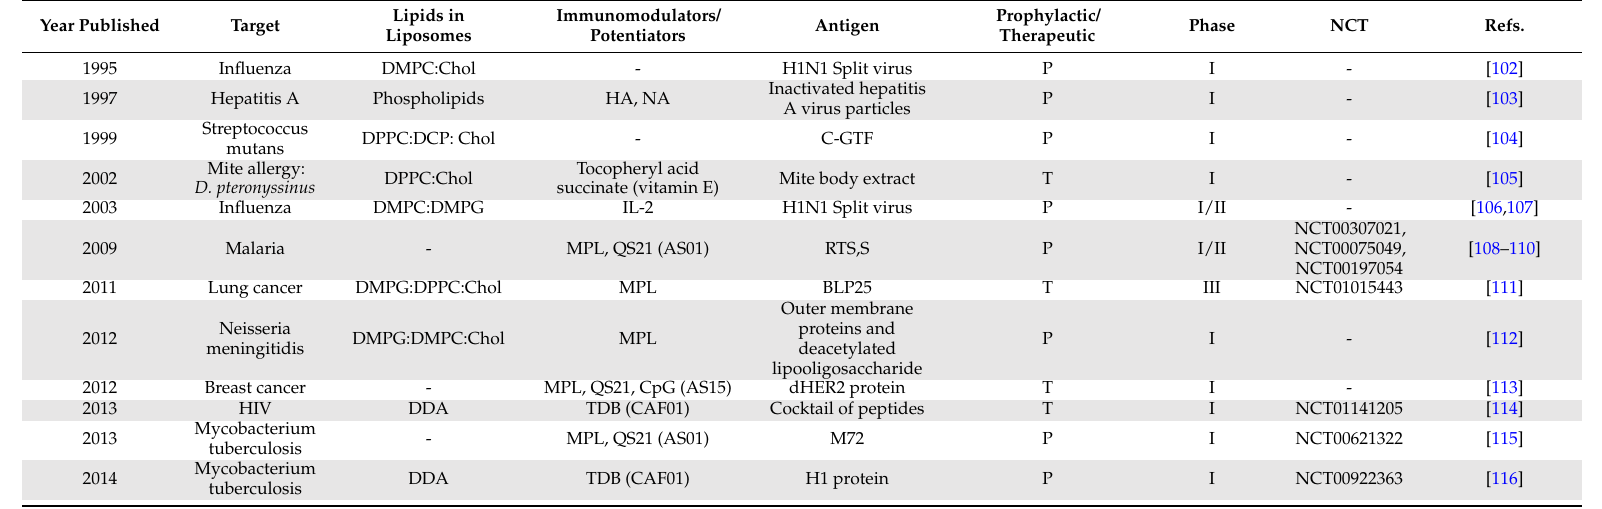
Table 1. Representative clinical trials using liposome-based adjuvants in vaccines. Representative examples of clinical trials evaluating liposome-based adjuvants in vaccines in the past 20 years. The targets for the liposome-based adjuvant vaccines are both prophylactic and therapeutic, covering a range of pathogens and diseases. Epaxal has been approved for human use. NCT: National Clinical Trial